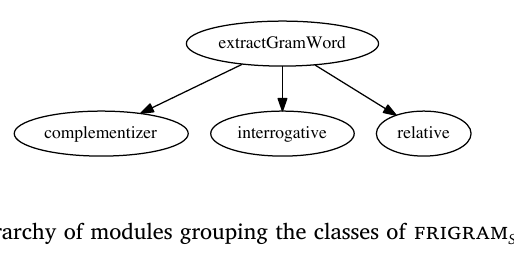
Figure 11: Hierarchy of modules grouping the classes of frigram S concerning